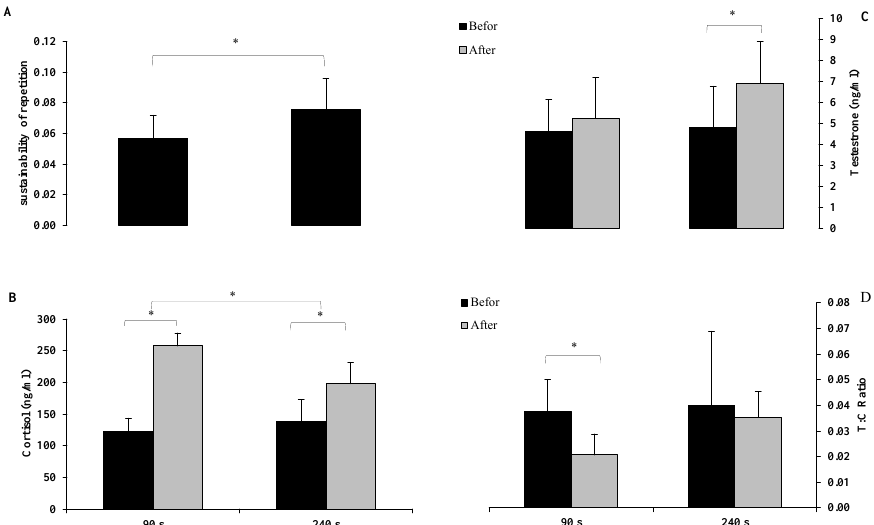
Fig 1. Means and standard deviations of (A) Sustainability of repetition, (B) Cortisol concentrations, (C) Testosterone concentrations, and (D) Testosterone to Cortisol (T:C) ratio, during 4 sets bench press in different trails. *, Significant difference between line-delineated trails;